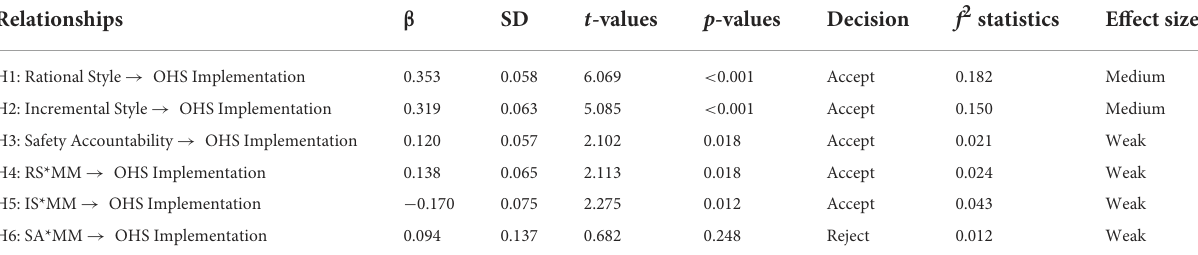
TABLE 5 Structural model: Hypothesized relationship testing and effect size.